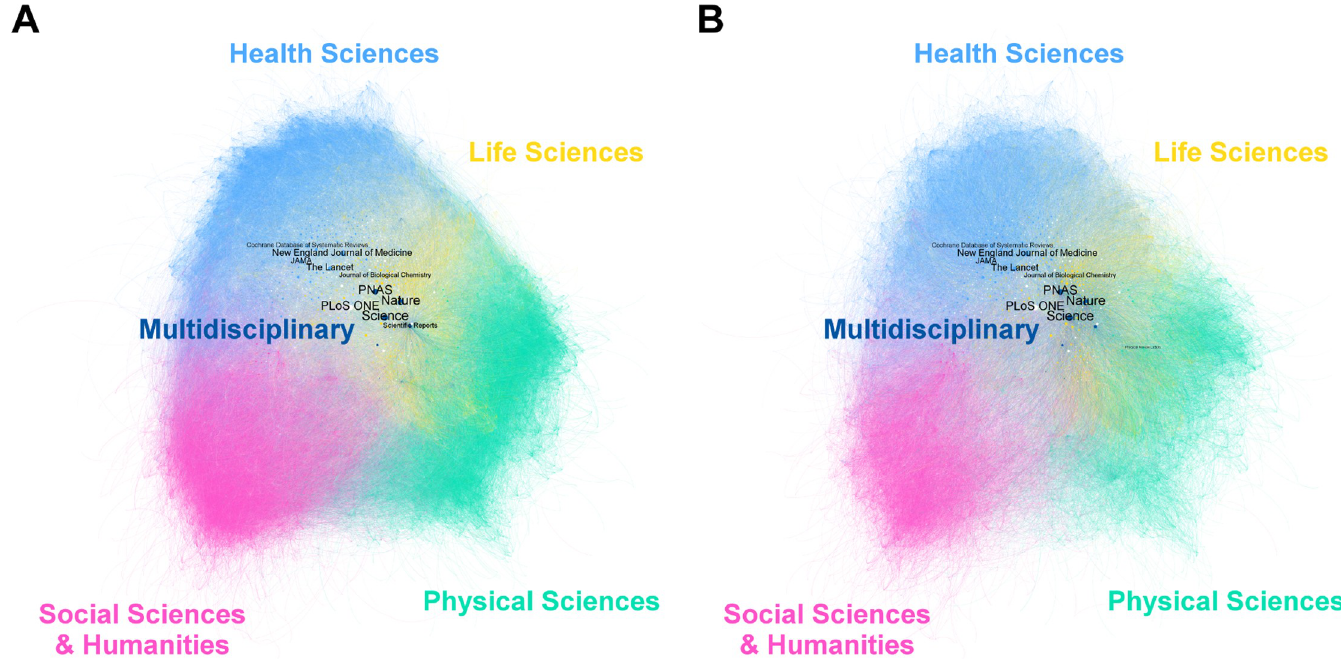
Fig 6. Co-citation network of journals based on Wikipedia article references. A) Main component of the full network; B) Pathfinder of the full network. Each node represents one journal and node size corresponds to the total number of citations received; color corresponds to the area but those with more than one are white; the thickness of the edges corresponds to the degree of co-citation between the two. The titles of the 10 journals with the highest intermediation value have been included.